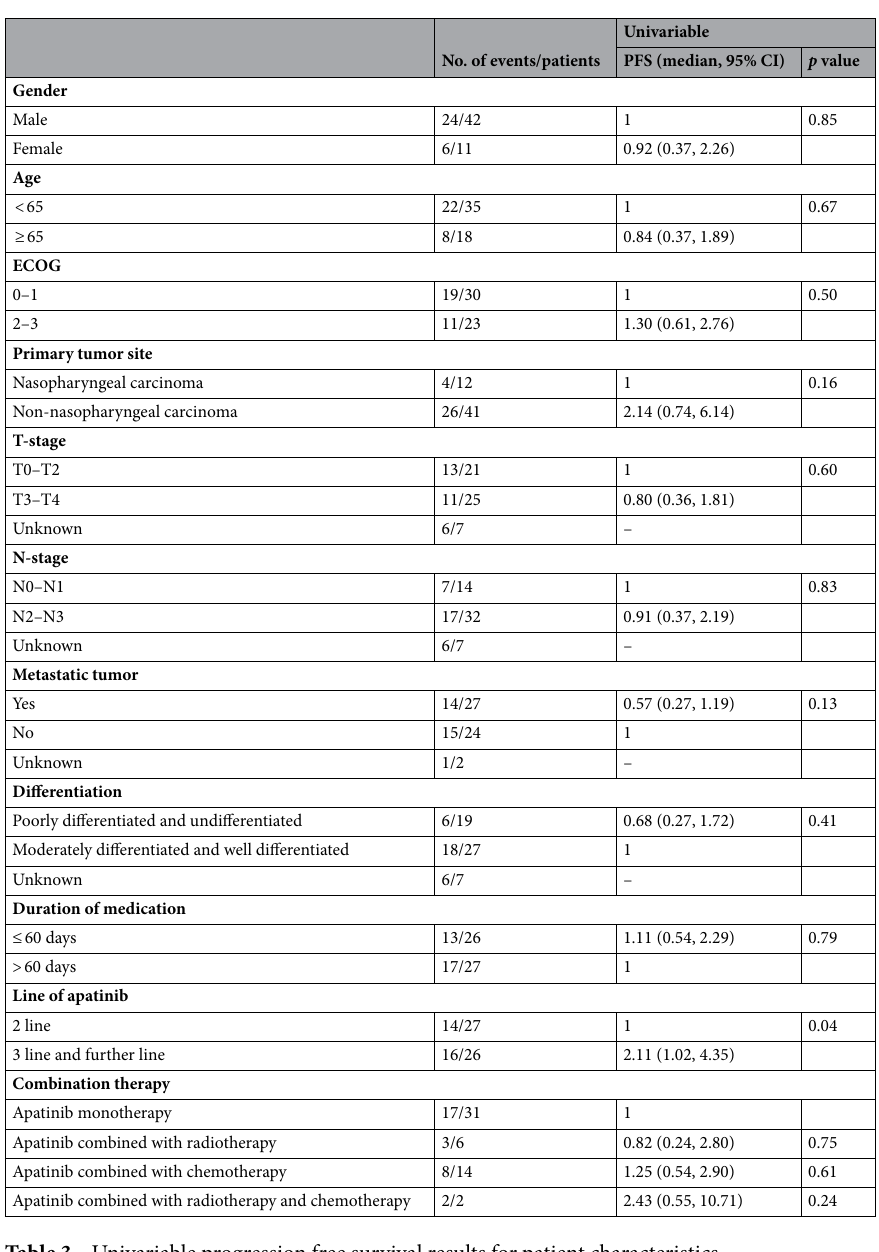
Table 3. Univariable progression free survival results for patient